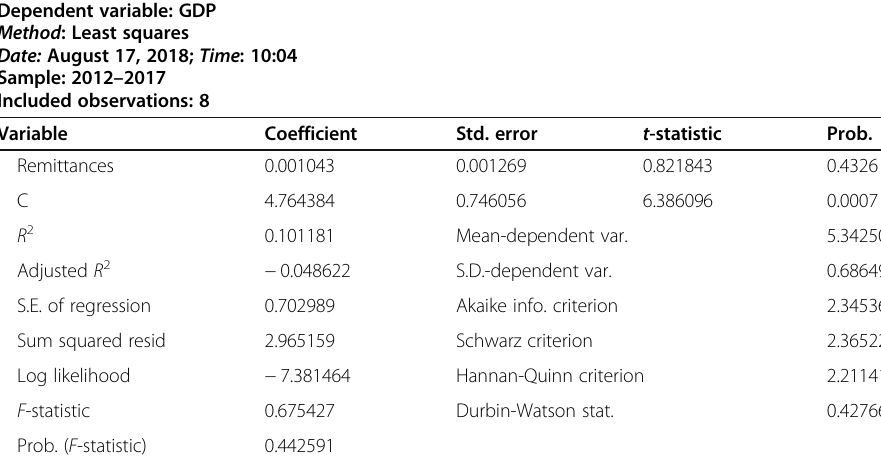
Table 6 Building the model with remittances as the only